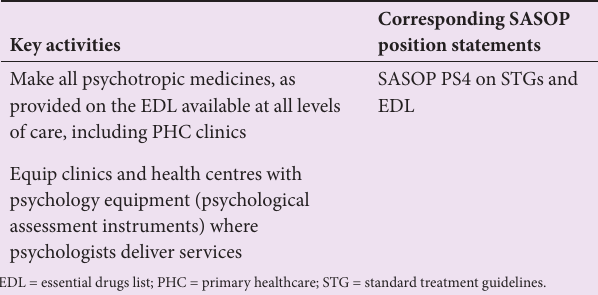
Table 5. Objective 5: Mental health technology, equipment and